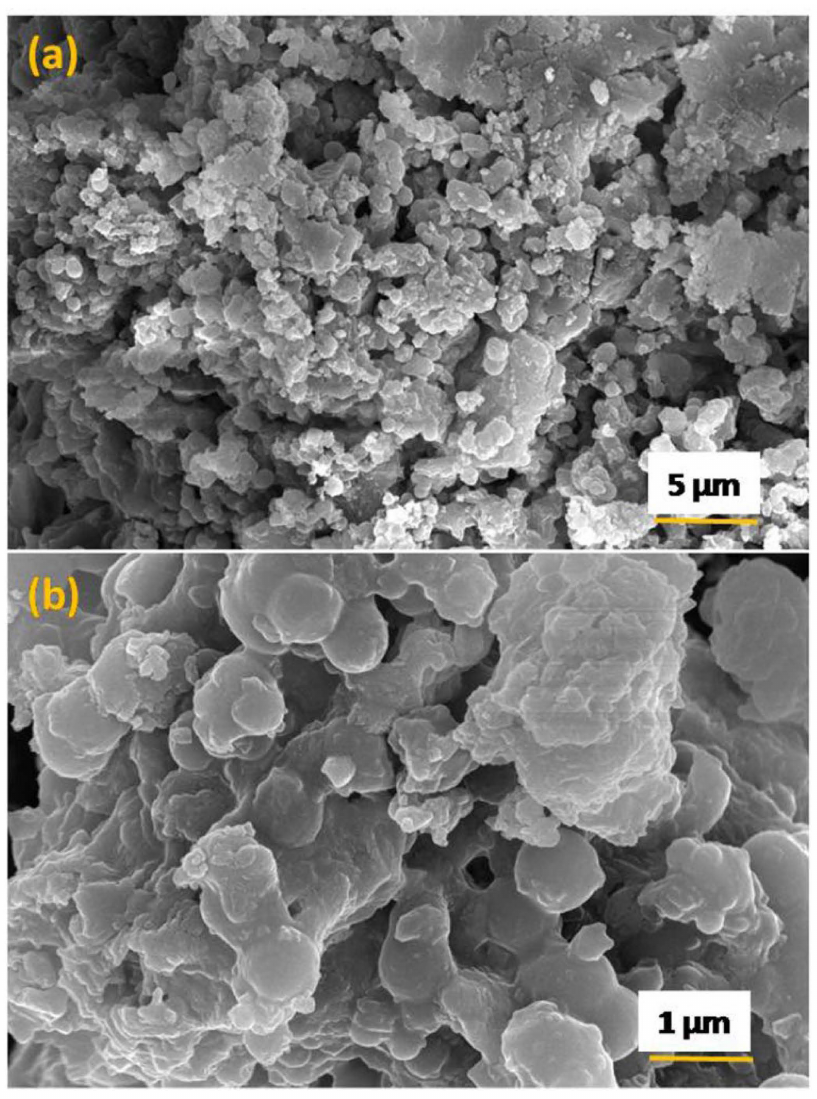
Figure 5. ( a , b ) FE-SEM micrographs of the Zn(OH) 2 /ZnO bionanocomposite at two different